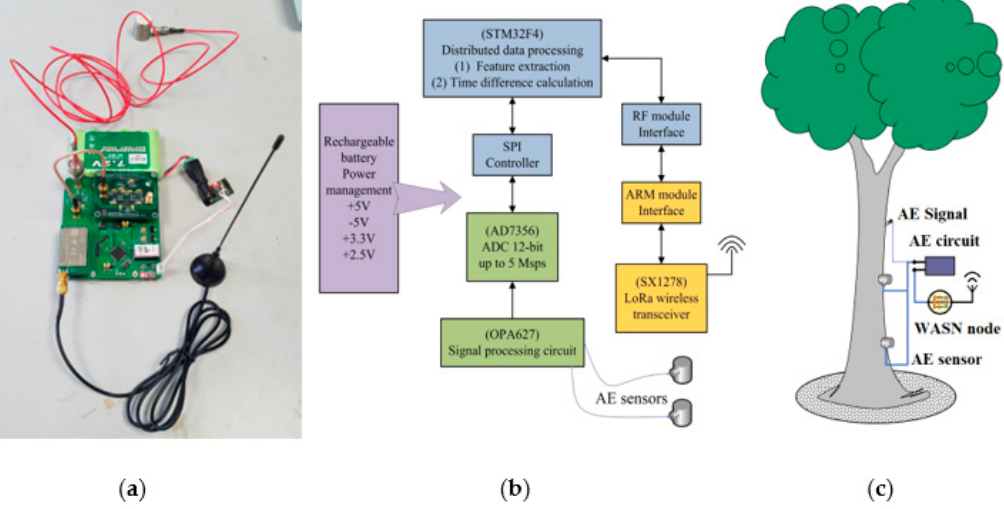
Figure 2. Field testing structure of WASN and its sample node: ( a ) sample of AE node; ( b ) architecture of the wireless AE node; ( c ) site installation diagram.